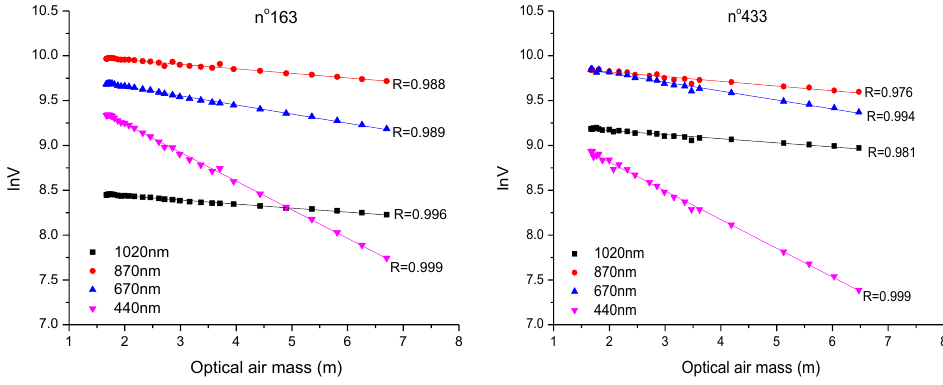
Figure 1. Calibration curves of the experimental instruments.